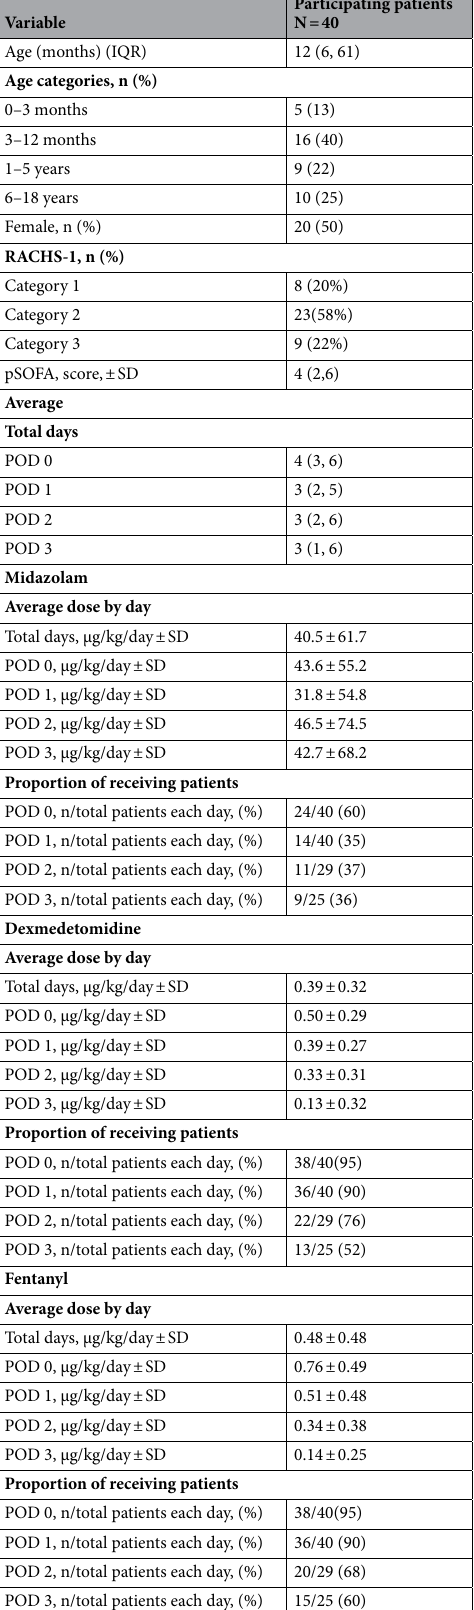
Table 1. Baseline characteristics of the patients. pSOFA: pediatric-sequential organ failure assessment score ,POD: Post-operative day, RACHS-1: Risk-Adjusted Congenital Heart